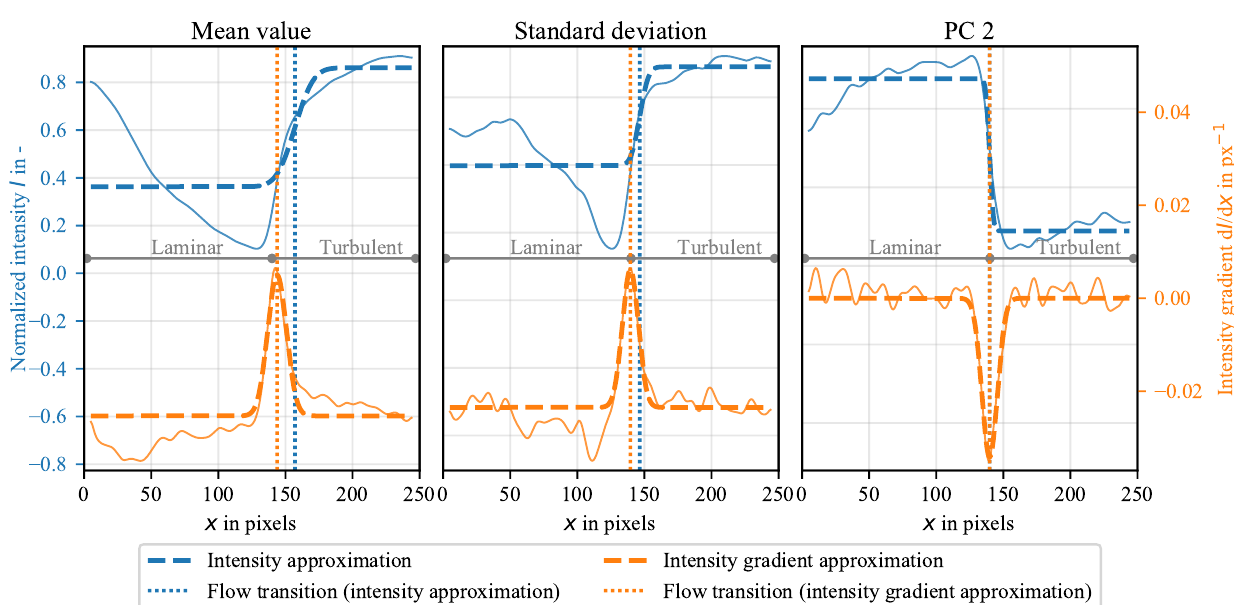
Figure 12. The intensity profile (blue line), intensity gradient profile (orange line) along the white dotted line in the temporal mean value, temporal standard deviation and PC 1 flow visualization in Figure 11. The approximation of the intensity profile (blue dashed) and intensity gradient profile (orange dashed), respectively. The flow transition localization results of both methods are depicted with a vertical dotted line in the respective color. Different expressions of the intensity plateaus are visible in each profile with varying gradient amplitudes between the plateaus. The most distinct expression of two plateaus including a steep step between them exists in the PC 2, even though the high gradient in the classical image processing result is sufficient for an auto-centering of the intensity gradient